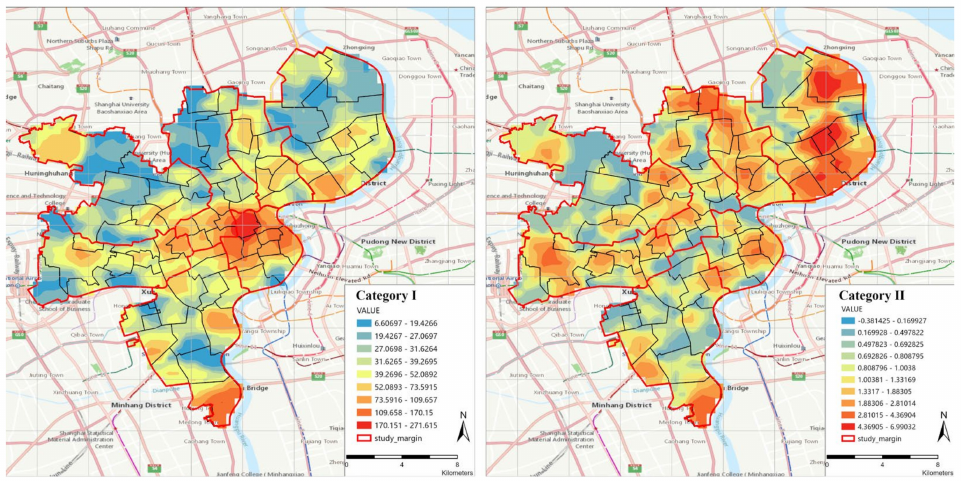
Figure 6. Kriging interpolation of two categories (without considering administrative region